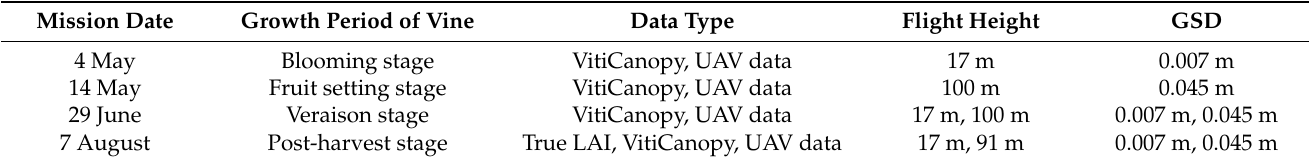
Table 1. Sampling date and corresponding growing seasons for true leaf area index (LAI), VitiCanopy and unmanned aerial vehicle (UAV)